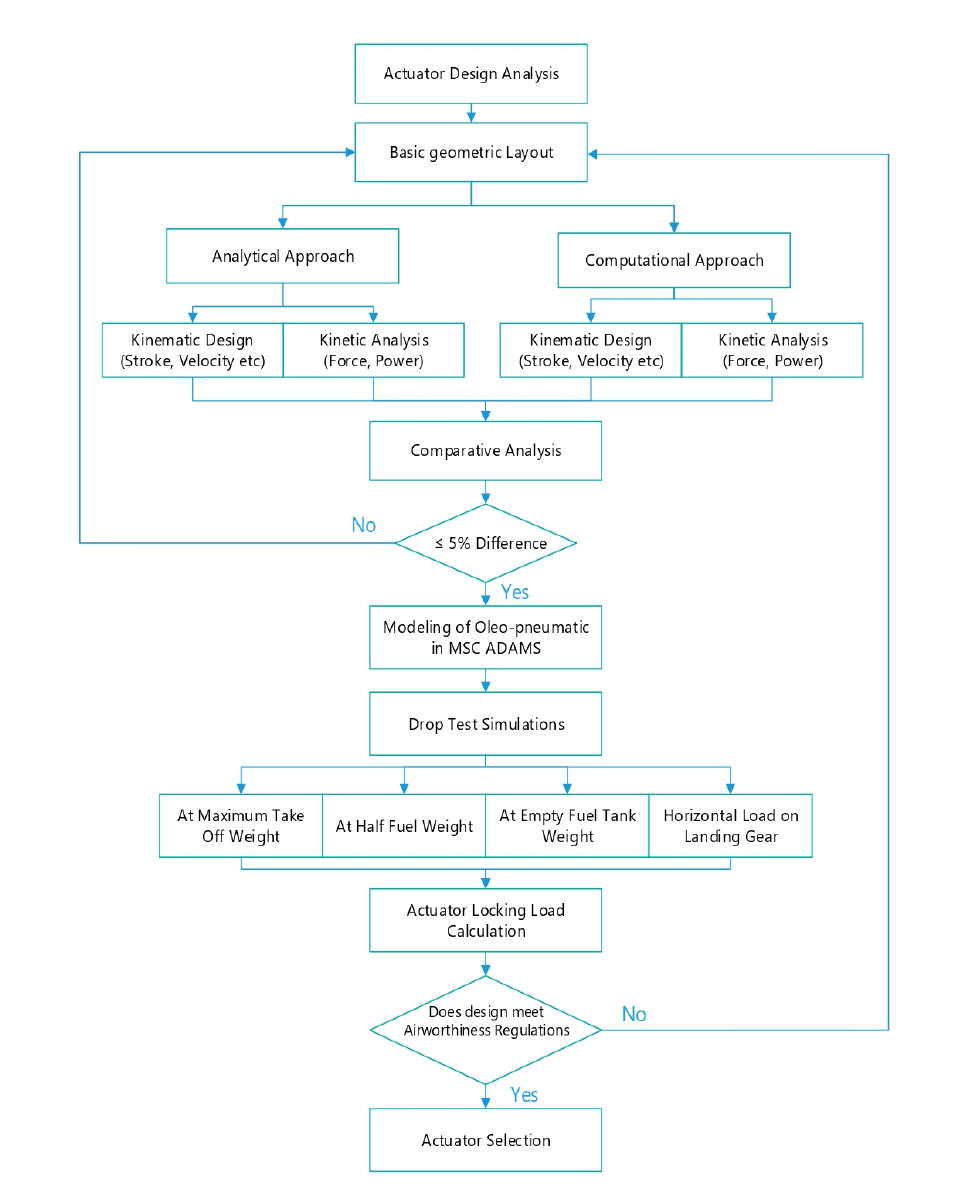
Figure 2. Proposed Selection